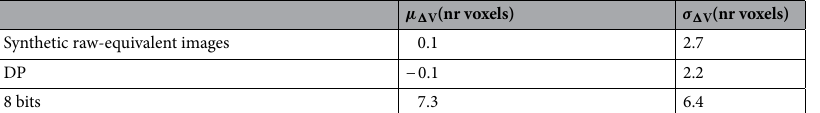
µ � V (nr voxels) σ � V (nr voxels) Synthetic raw-equivalent images 0.1 2.7 DP − 0.1 2.2 8 bits 7.3 Table 2. Parameters of the difference in the single-object volume (∆V) obtained from the synthetic and compressed LS 3D image with respect to the raw format (Fig. 3g).